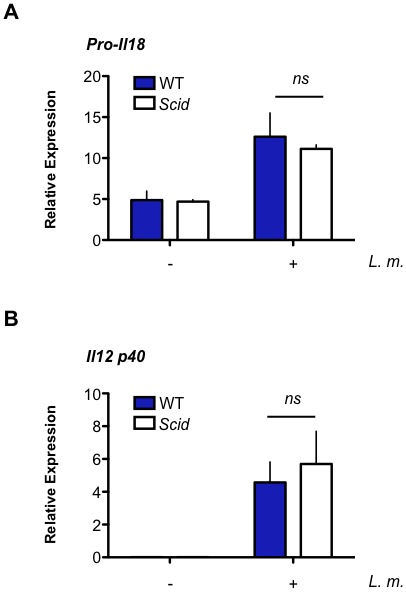
Il18 and Il12 gene expression is equivalent in WT and Scid BMDM after L.m. infection.(A,B) Quantitative RT- PCR analysis of (A) Pro Il18 and (B) Il12p40 gene expression in WT and Scid BMDM 12 hr post- L. m. infection. Data are a compilation of three independent experiments and depict mean and SEM. ns = not significant.